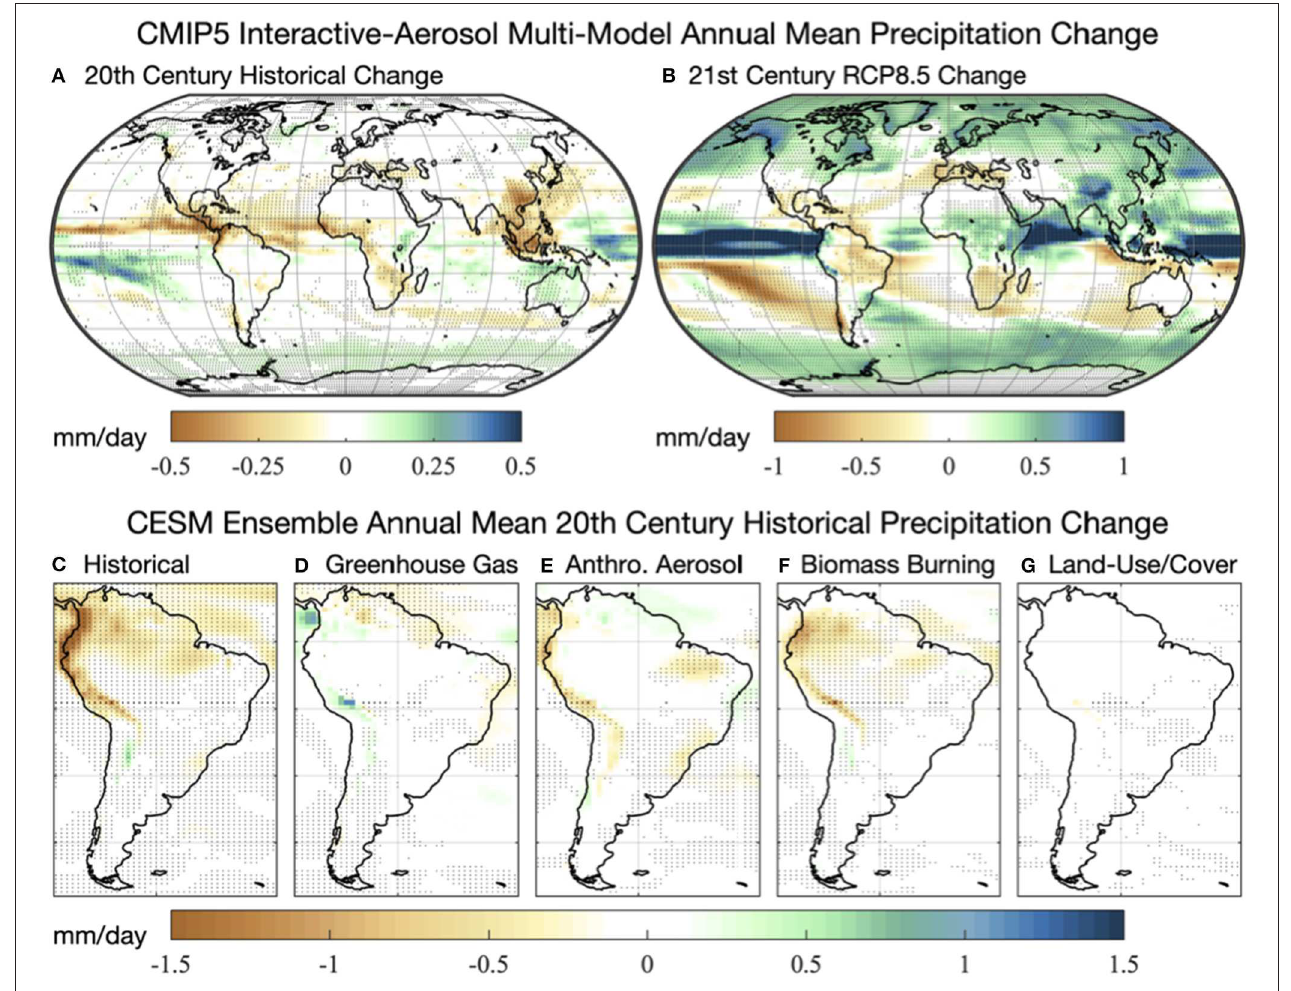
FIGURE 1 | Annual mean precipitation changes from (A) CMIP5 historical simulations (1971–2000 to 1871–1900), (B) CMIP5 RCP8.5 simulations (2071–2100 to 1971–2000), (C) CESM ensemble mean historical simulations (1971–2000 to 1850), and (D–G) contributions from single forcings as described in the text. Stippling in (A,B) indicates where 8 of 10 models have the same sign of change. Stippling in (C) indicates where changes are statistically significant at 95% confidence across 35 ensemble members. Stippling in (D–G) indicates where a single forcing contributes to at least 50% of the full historical